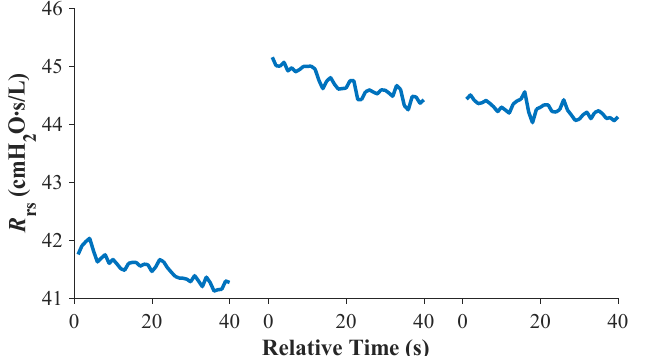
Figure 3. The course of computed R rs during ventilation of the respiratory system model without an added resistor (three 40 s long measurements correspond to measurement sections 1, 2, and 3 in Figure 2). Three glass demijohns with different compliance (37, 24, and 17 mL/cmH 2 O) were ventilated to investigate the effect of compliance on the measured resistance of the respiratory